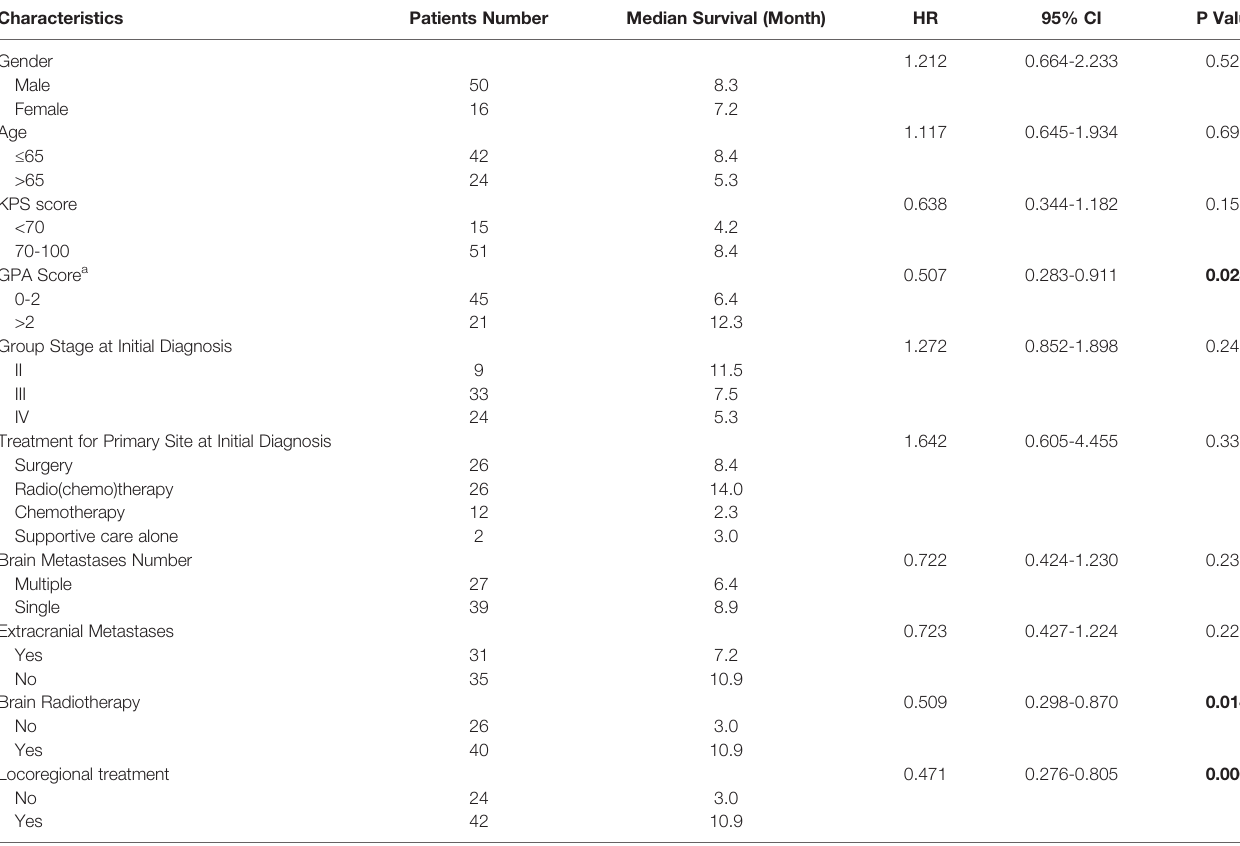
TABLE 3 | Univariate analysis of various potential prognostic factors for survival in patients.